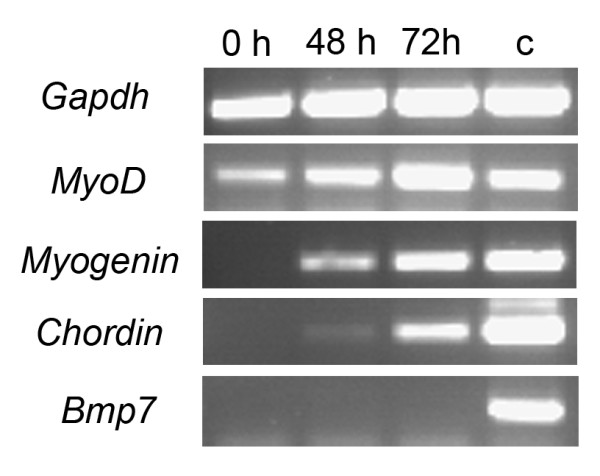
Chordin expression is upregulated in myofiber cultures. Gapdh, MyoD, Myogenin, Chordin and Bmp7 expression was analyzed by RT-PCR of myofiber cultures at 0, 48 and 72 hours. cDNA of an E 12.5 embryo was used as a control. Chordin expression follows the expression of Myogenin.